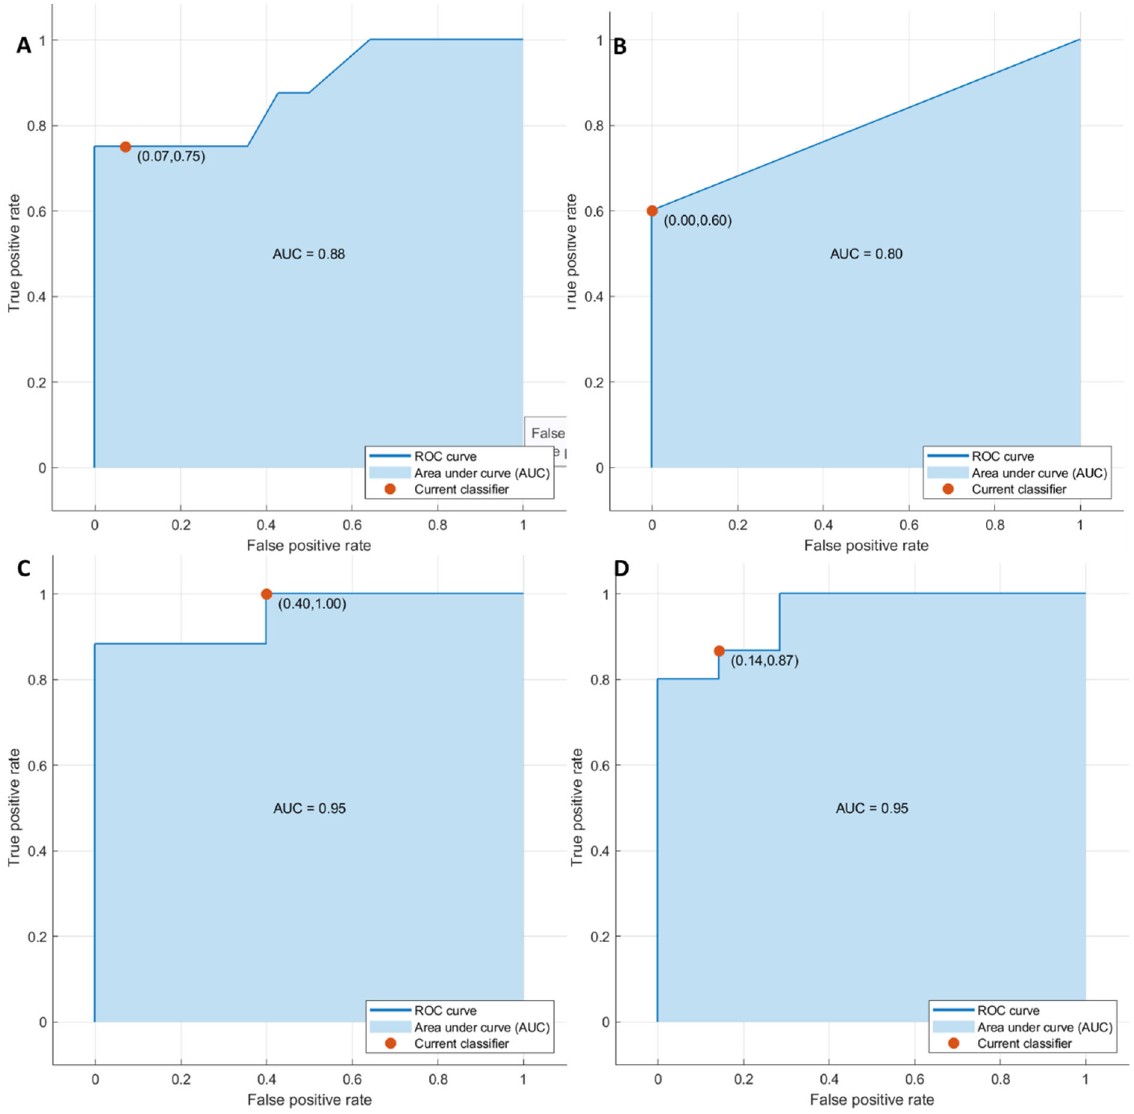
Figure 3. ROC curves of KNN with respect to the front of tumor growth ( A ), tumor budding ( B ), tumor mucinous type ( C ), and recurrence presence ( D ) obtained considering significant features in external validation test.